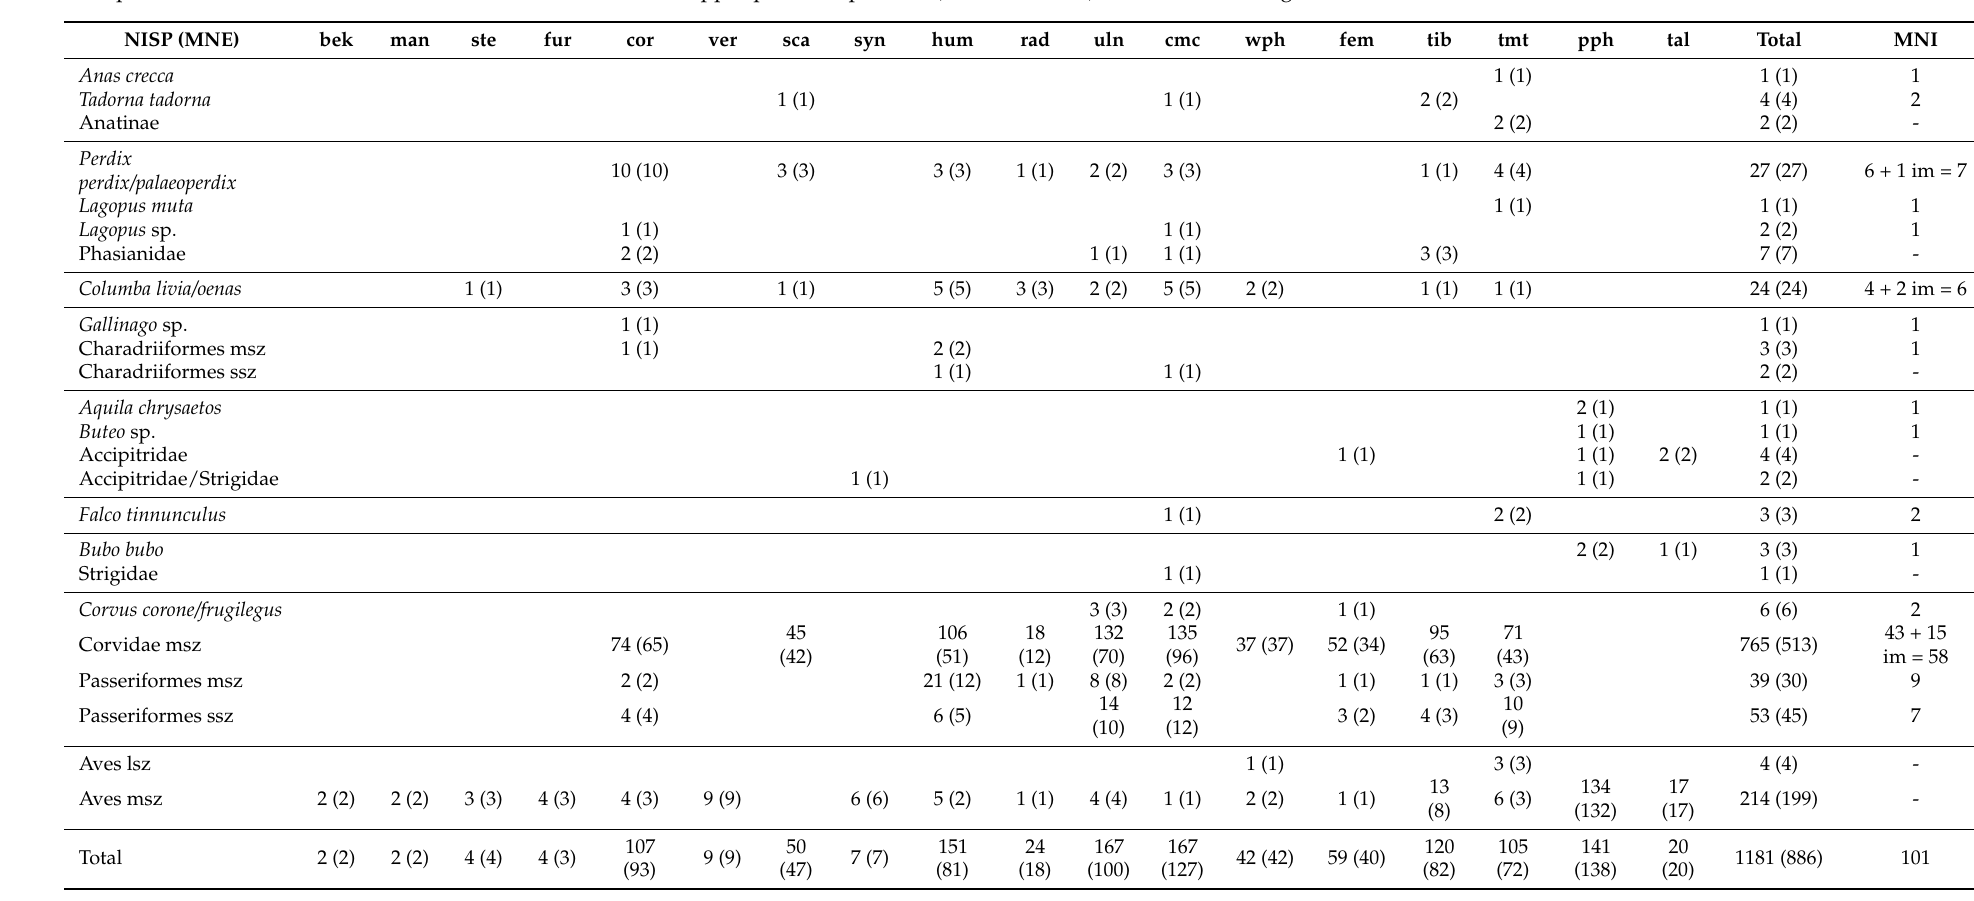
Table 1. NISP and MNE present at layer VIII of Grotte Vaufrey. MNE indicated inside the brackets. MNI indicated in the last column, specifying the number of immature (im) individuals. Bek: beak; man: mandible; ste: sternum; fur: furcula; cor: coracoid; ver: vertebra; sca: scapula; syn: synsacrum; hum: humerus; rad: radius; uln: ulna; cmc: carpometacarpus; whp: